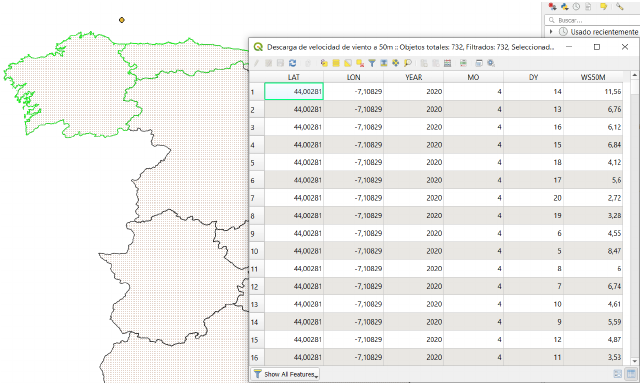
Figure 20. NASA Power Larc: Wind speed (m/s) at 50 m. Data source